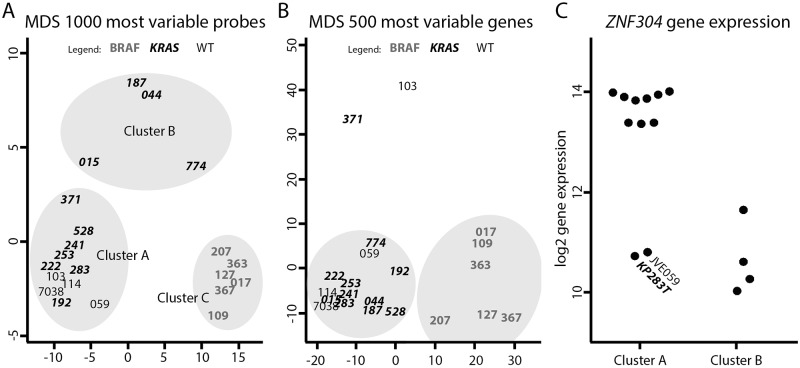
Clustering of gene expression and DNA methylation data.To minimize overlap between cell line names, only the numbers corresponding to the cell lines were displayed. MDS analysis of DNA methylation data shows a distinct cluster of BRAF mutant cell lines; cluster C. Secondary clustering is formed by KRAS mutant samples with low ZNF304 expression (cluster B, Figure 2A). MDS analysis of gene expression data showed BRAF mutant samples cluster separately from KRAS mutant and WT samples (2B). The cell lines in cluster B show a 5.9-fold lower ZNF304 expression compared to the cell lines in cluster A (2C).